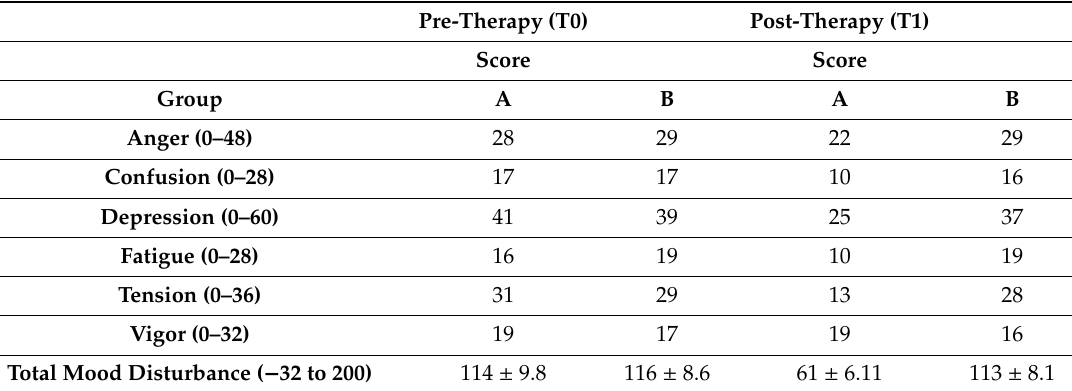
Table 1. Profile of Mood States (POMS).